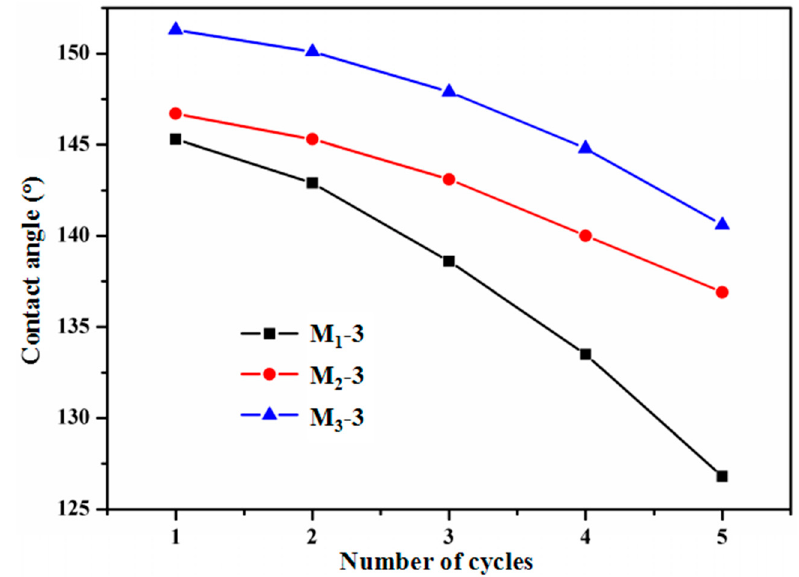
Figure 9. Typical curve of AWCA of PTFE / HSPVC composite films in five cycles of adhesion and stripping between samples and copper foil adhesive tape.